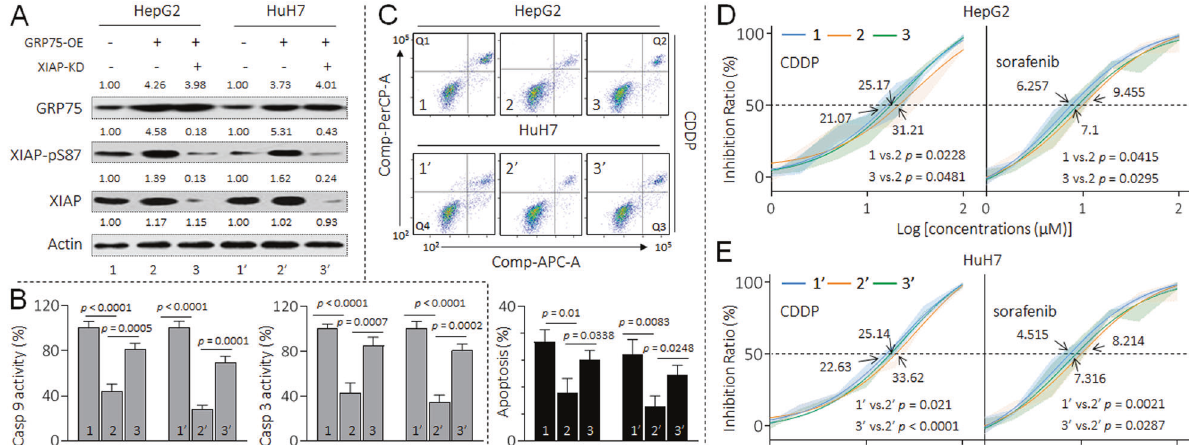
Fig. 6 Veri fi cation of the results in vitro. HepG2 and HuH7 cells were transfected with GRP75-plasmid in the presence or absence of XIAP- siRNA. A Western blot analysis of the expressions of GRP75, XIAP(p-S87), and XIAP. B Relative caspase-9/3 activities. C Flow cytometric analyses of the percentage of cells in apoptosis under the treatment of 10.0 μ M cisplatin. D and E Cell viability was determined in triplicate, and the IC 50 s were calculated.